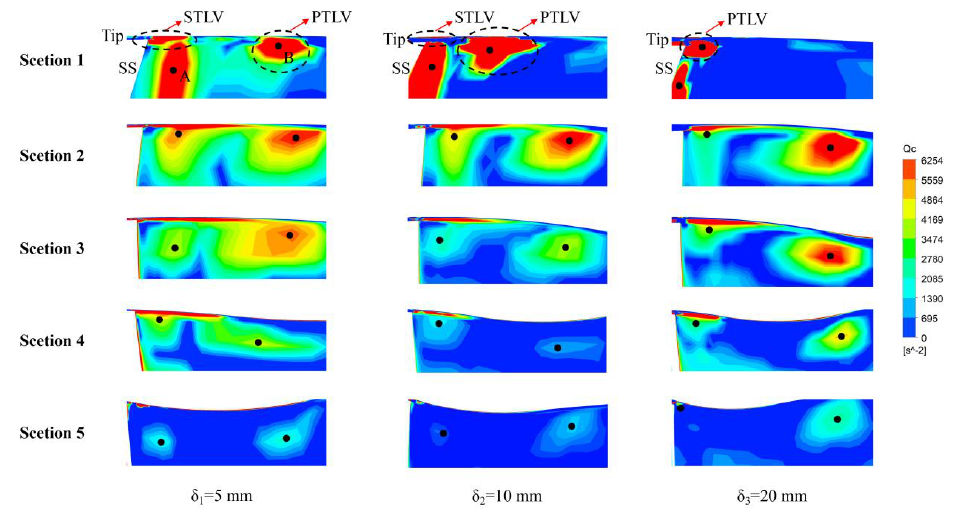
Figure 14. Vortex intensity distribution at each section under different gaps.